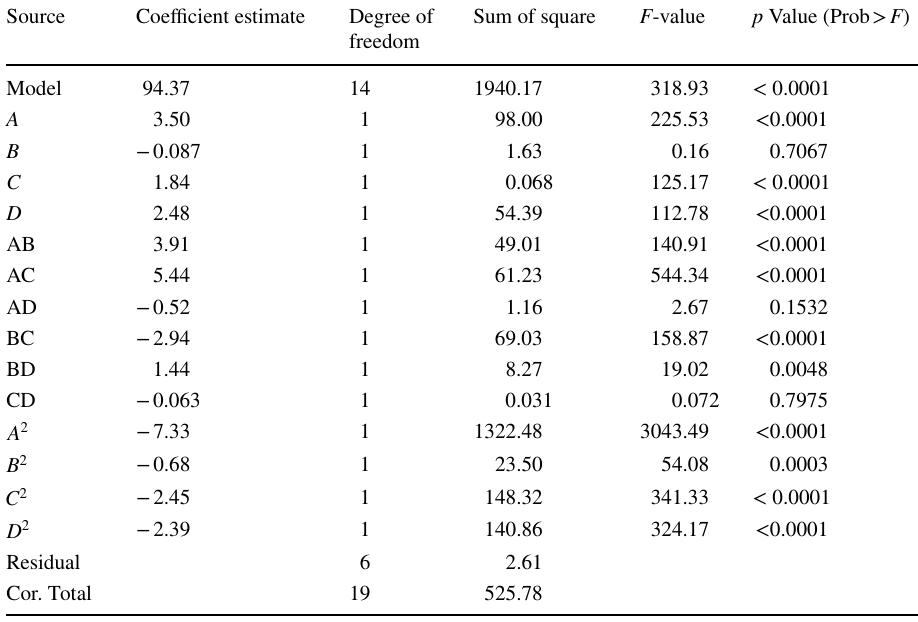
Table 6 Significance of regression coefficients of the adsorption efficiency of coal-based activated carbon in the treatment of fibre cement industry effluent using Design expert